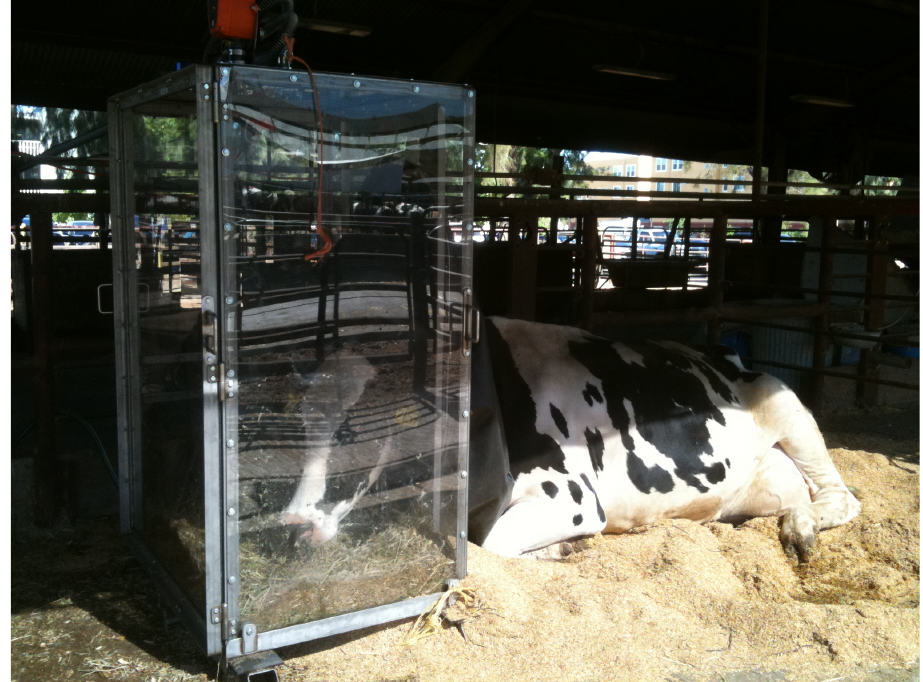
Figure 3. An example of a cow lying down while her eructated and respired emissions are being measured in the head hood.